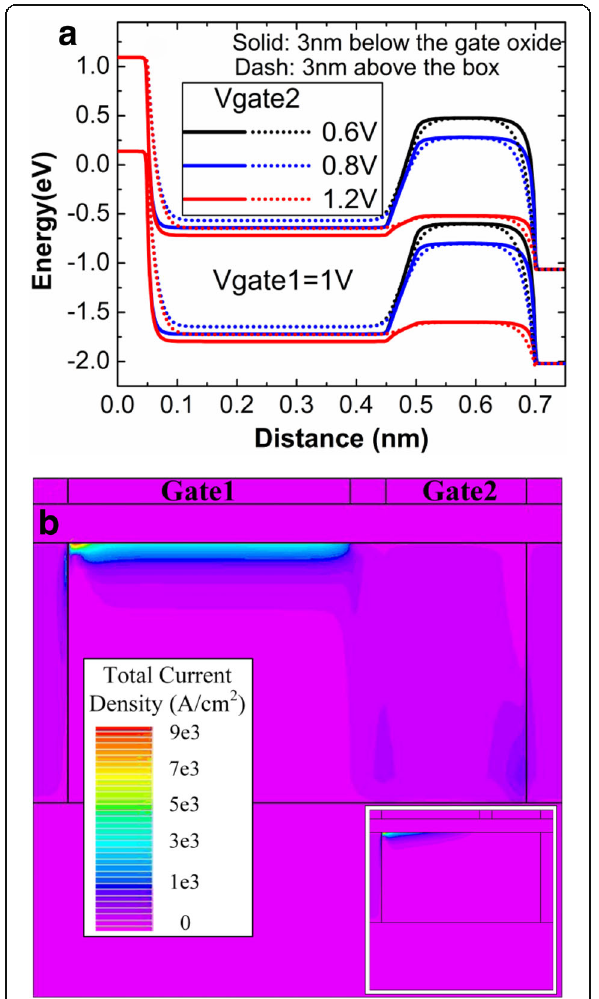
Fig. 7 a Energy band diagram and b total current density after reading “ 0 ” . a , b The energy band and total current density after reading “ 0 ” , respectively. The energy band is extracted at the 3 nm below the gate oxide